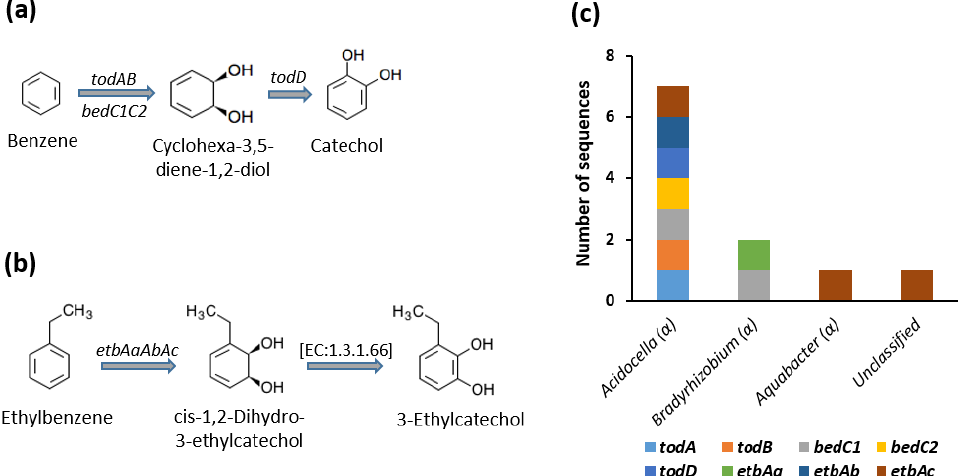
Figure 1. The activation of ( a ) Benzene and ( b ) Ethylbenzene by respective dioxygenases. ( c ) Genus assignation of the genes involved in benzene and ethylbenzene activation. Symbol in parenthesis indicate the taxonomic class of each genus. todAB and bedC1C2 : benzene/toluene dioxygenases; todD : cis-1,2-dihydrobenzene-1,2-diol/chlorobenzene dihydrodiol dehydrogenase; etbAaAbAc : ethylbenzene